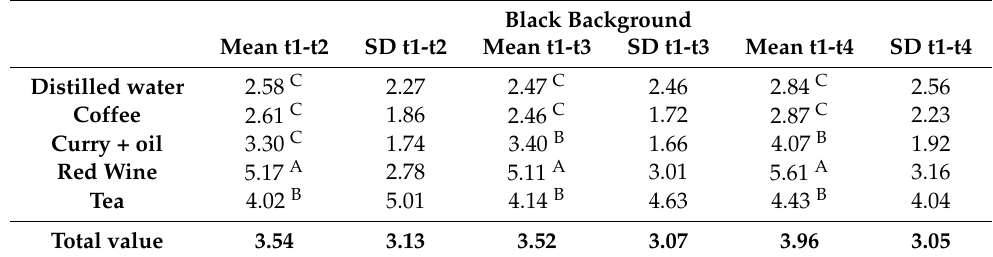
Table 7. Mean and Standard Deviations of CIEDE00 color differences over time according to different staining liquids analyzed over a black background. ABC rankings are from the highest ( A ) to the lowest staining results using Fisher’s LSD post hoc test at a p -value <